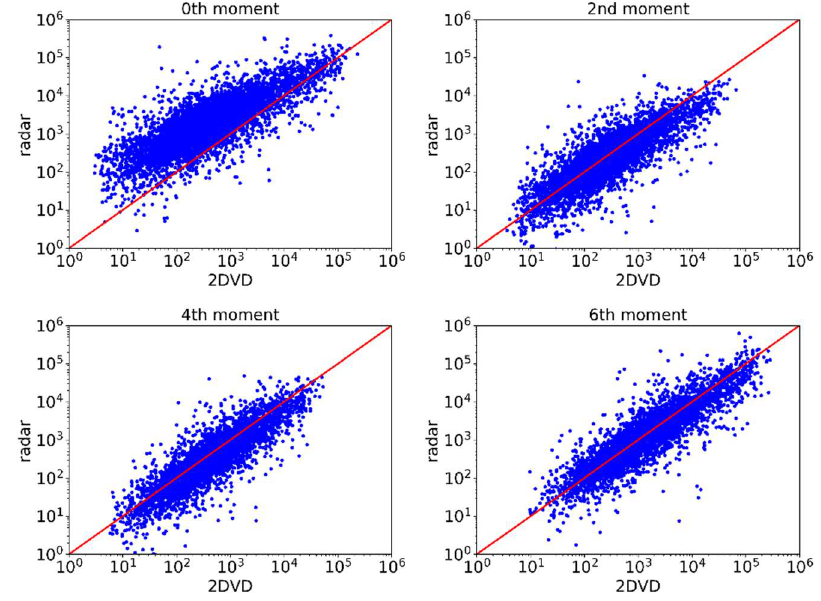
Figure 12. Comparison of the DSD moments retrieved by the inverse model: ( a ) the zeroth-moment; ( b ) the second-moment; ( c ) the fourth-moment; and ( d ) the sixth-moment. Table 5. Root mean square error (RMSE), mean absolute error (MAE), root relative square error (RRSE), relative absolute error (RAE), and correlation coefficient (CC) for the zeroth, second, fourth, and sixth moments, respectively. RMSE MAE RRSE RAE CC